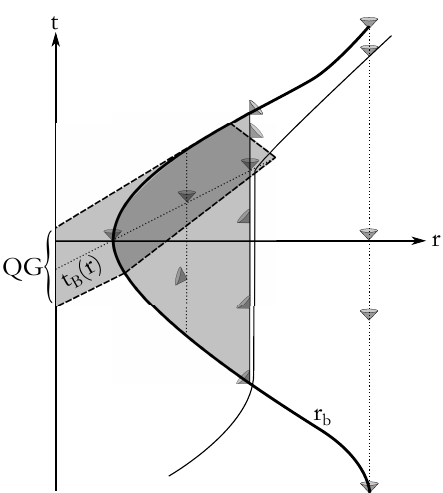
Figure 5. Finkelstein diagrams for the black hole to white hole transition with asymmetry in time. The grey area enclosed within dashed lines represents the region where quantum effects are important (QG). The grey area within solid lines represents the trapped region in the exterior space-time. The solid thick line r b represents the boundary of the cloud. The solid thin vertical line represents the horizon in the exterior region. In the time asymmetric transition, the bounce curve t B ( r ) (dotted line) is not constant (see Figure 2 for comparison with the symmetric case). An horizon grazing photon (thin curved line) remains in the vicinity of the horizon for longer time with respect to the symmetric case. The lifetime of the white hole is short as compared with the lifetime of the black